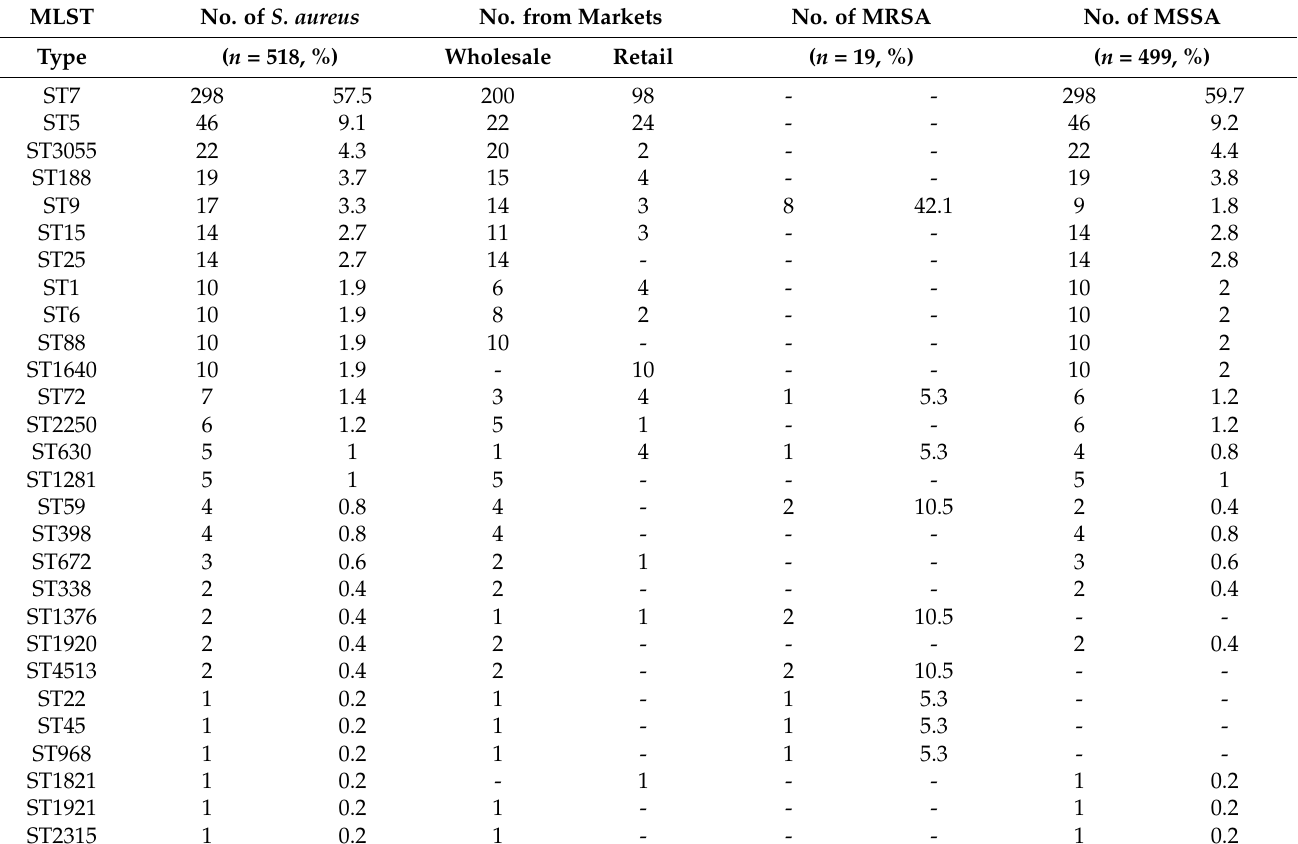
Table 2. Overview of S. aureus prevalence in wholesale and retail pork in Wuhan, central